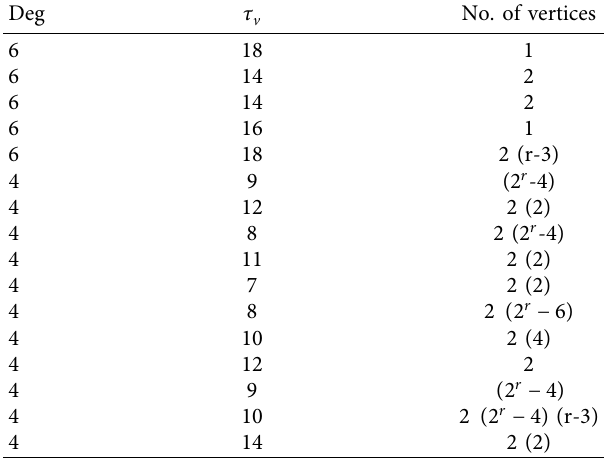
Table 2: Vertex partition of TB ( r ) corresponding to connection numbers and